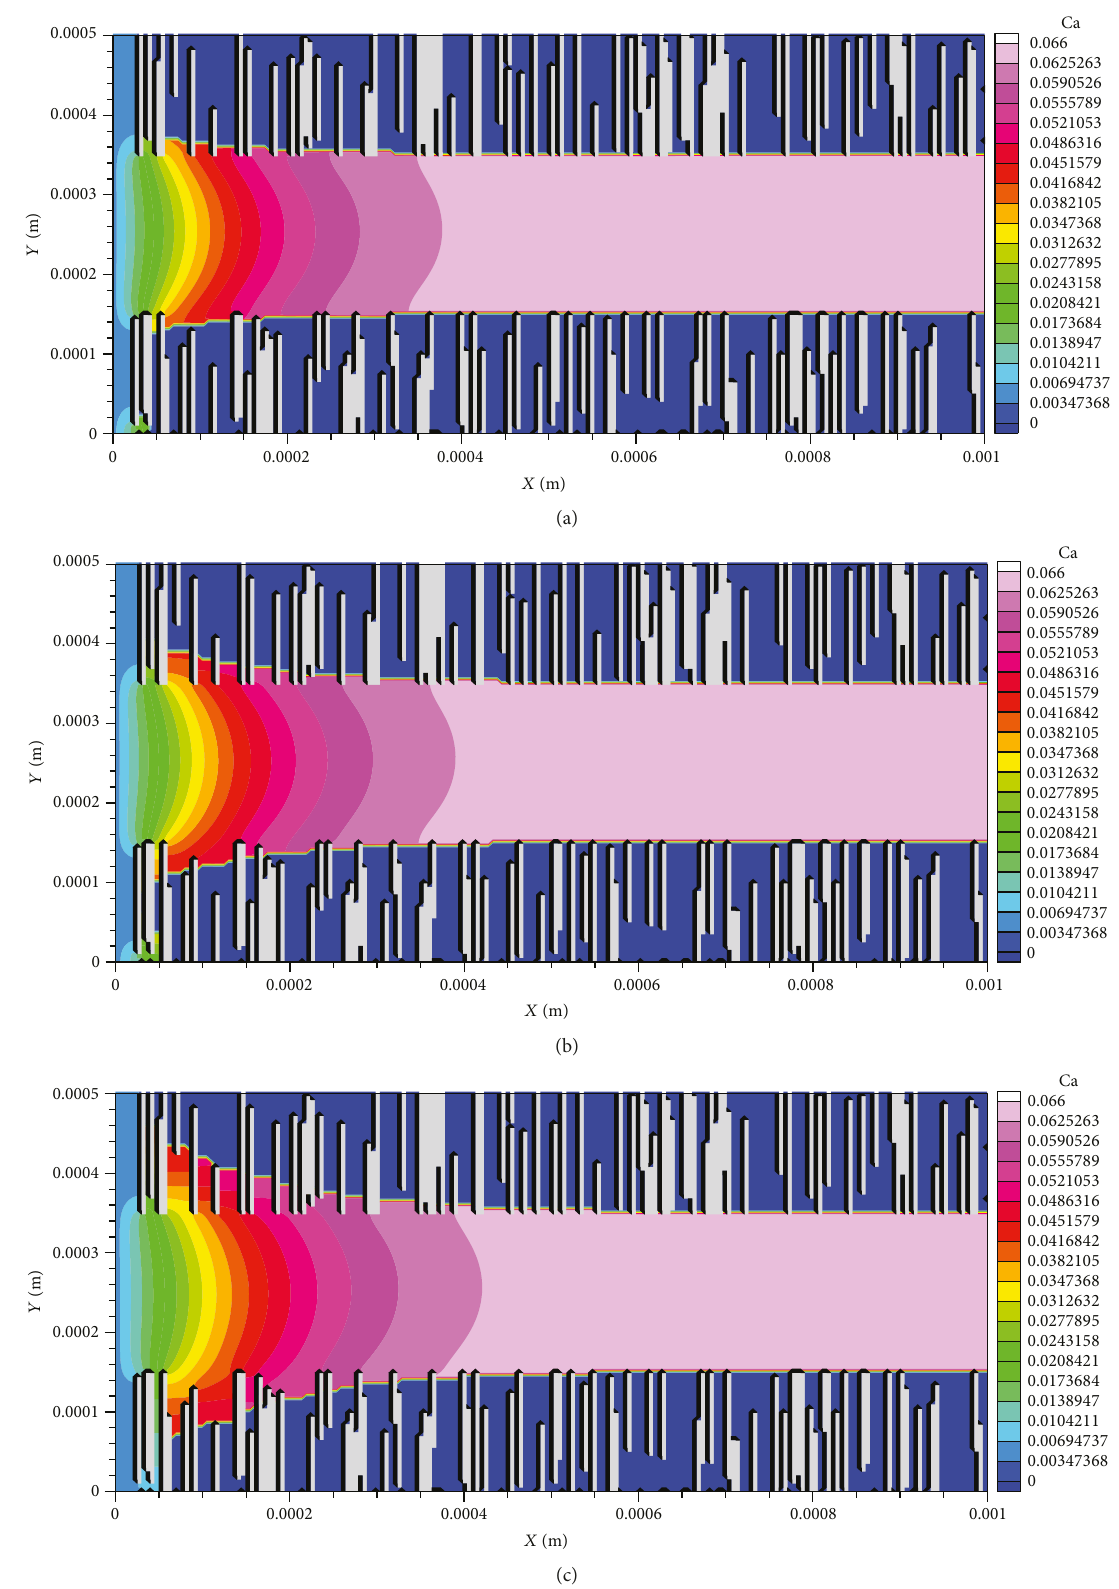
Figure 22: Ca concentrations (mol/L) at (a) t = 5 1 hr, (b) t = 12 6 hr, and (c) t = 29 3 hr. In all three cases, Pe =0.026 and kaolinite is illustrated in light